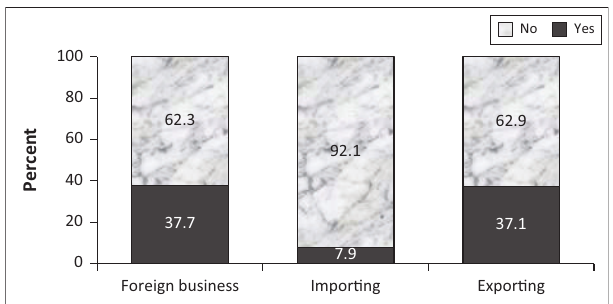
FIGURE 9: Engagement with foreign businesses.